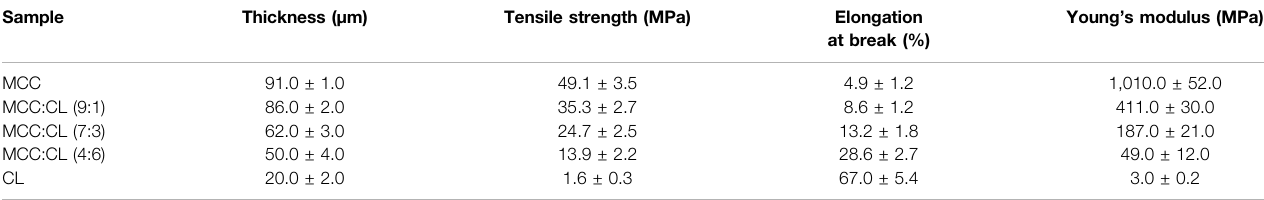
TABLE 1 | Tensile properties of the MCC fi lm, CL extract, and MCC:CL biocomposite fi lms. Sample